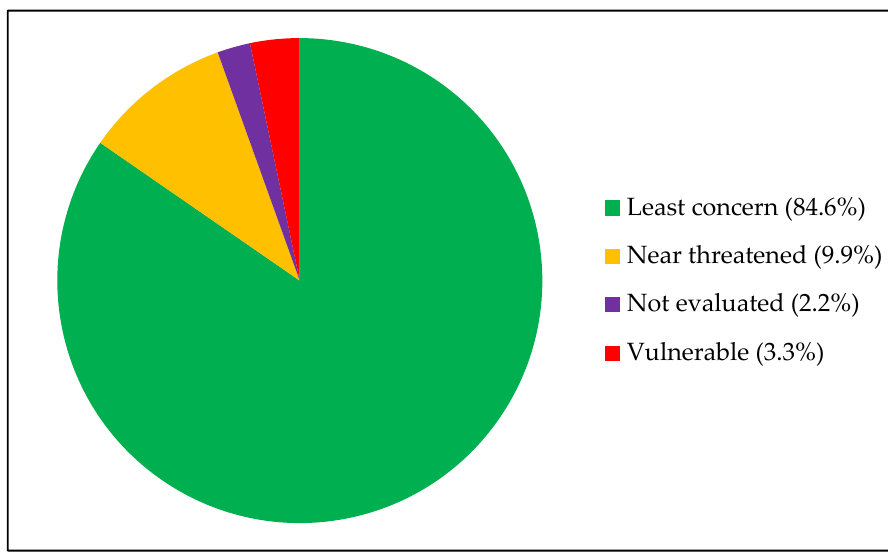
Figure 7. Global conservation status of fish species.